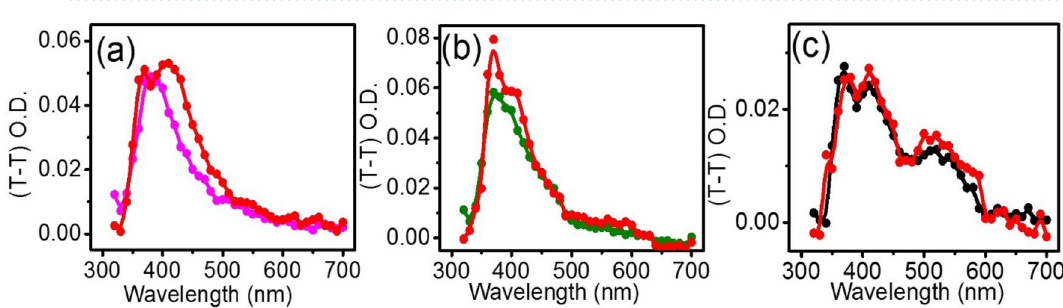
Figure 5. Transient absorption spectra of ( a ) ADN, ( b ) Au MQ-ADN and, ( c ) Fe MQ-ADN, respectively, between the pump and probe pulse at 1 μs time delay and all the red spectra represent the presence of the magnetic field for their corresponding spectra. The decay spectra at 380, 420, and 520 nm wavelength are given in supplementary information